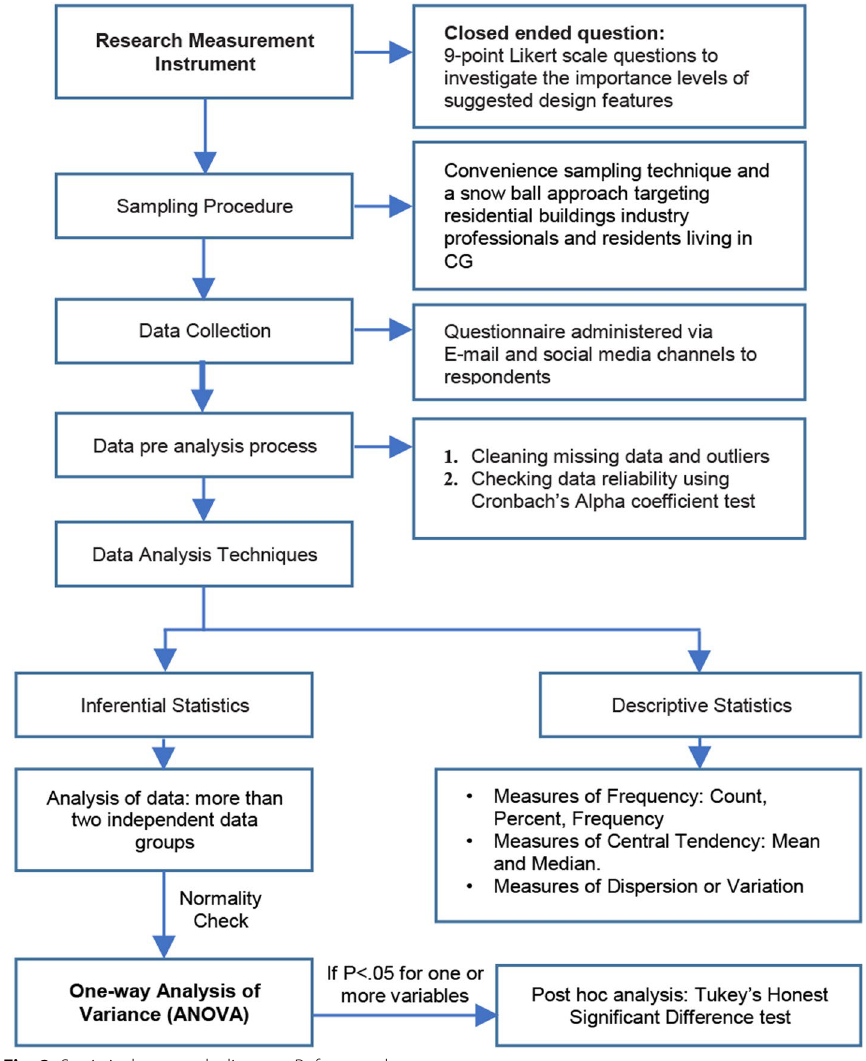
Fig. 2 Statistical approach diagram. Ref: